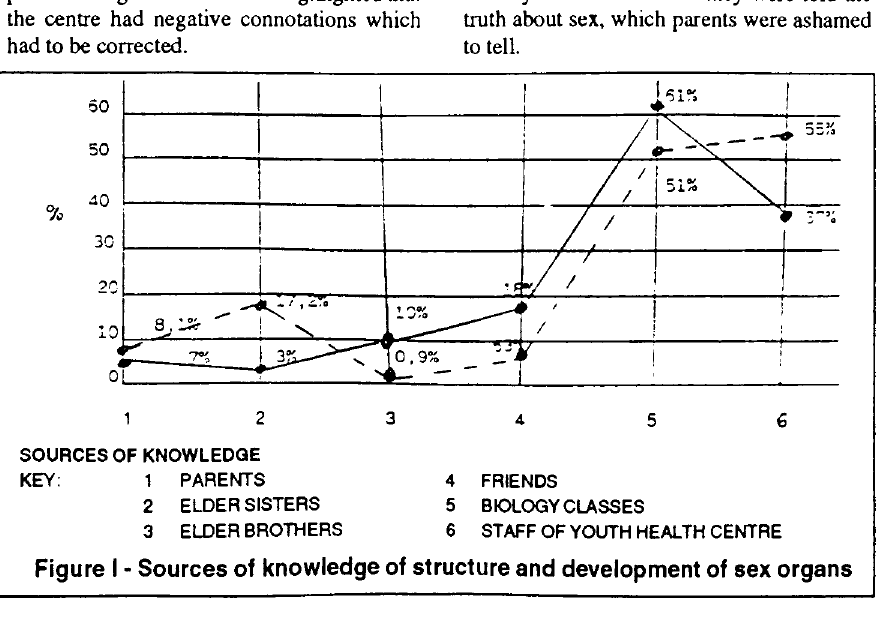
Figure I - Sources of knowledge of structure and development of sex